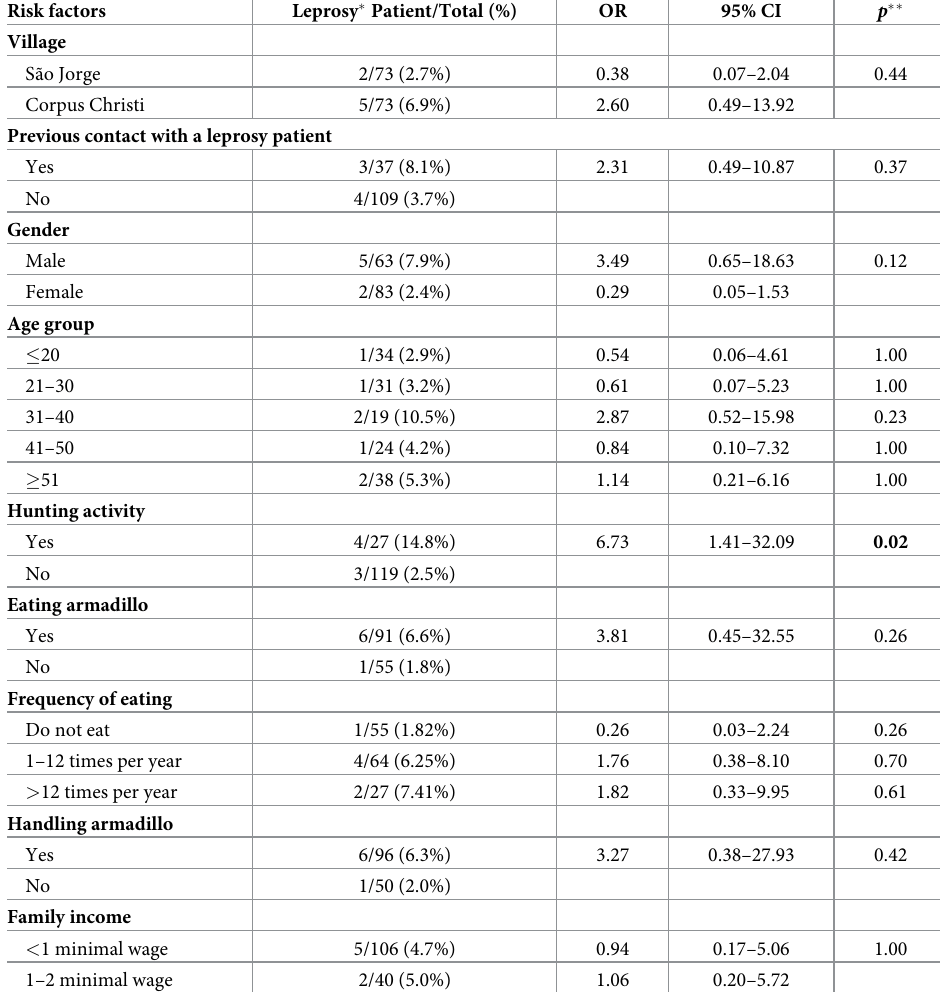
Table 1. Risk factors associated with leprosy patients living in rural communities in the municipality of Belterra, Para´.